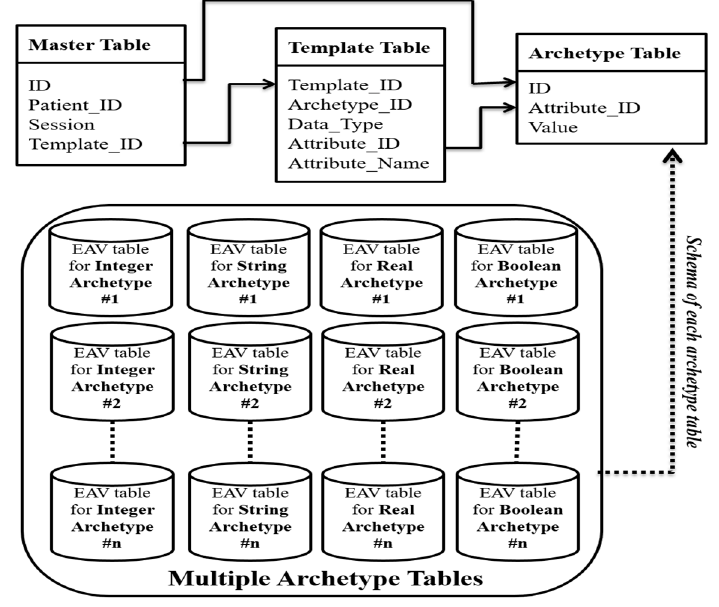
Figure 3. Modified entity attribute value storage model.